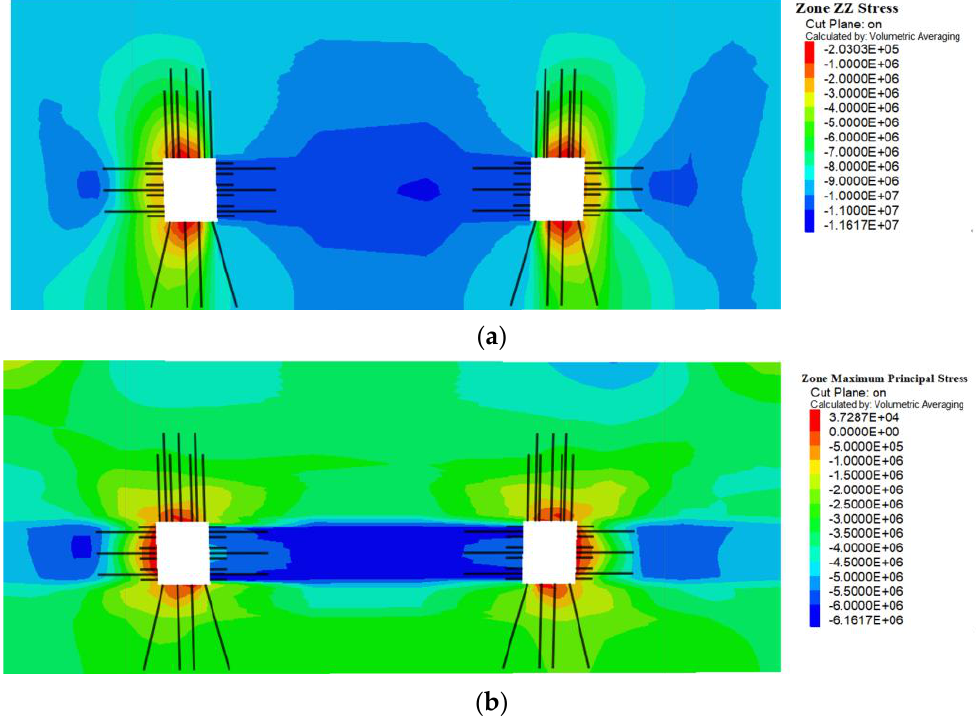
Figure 14. A stress cloud chart of LBG control technology. ( a ) A vertical stress cloud chart of LBG control technology; and ( b ) a maximum principal stress cloud chart of LBG control technology.